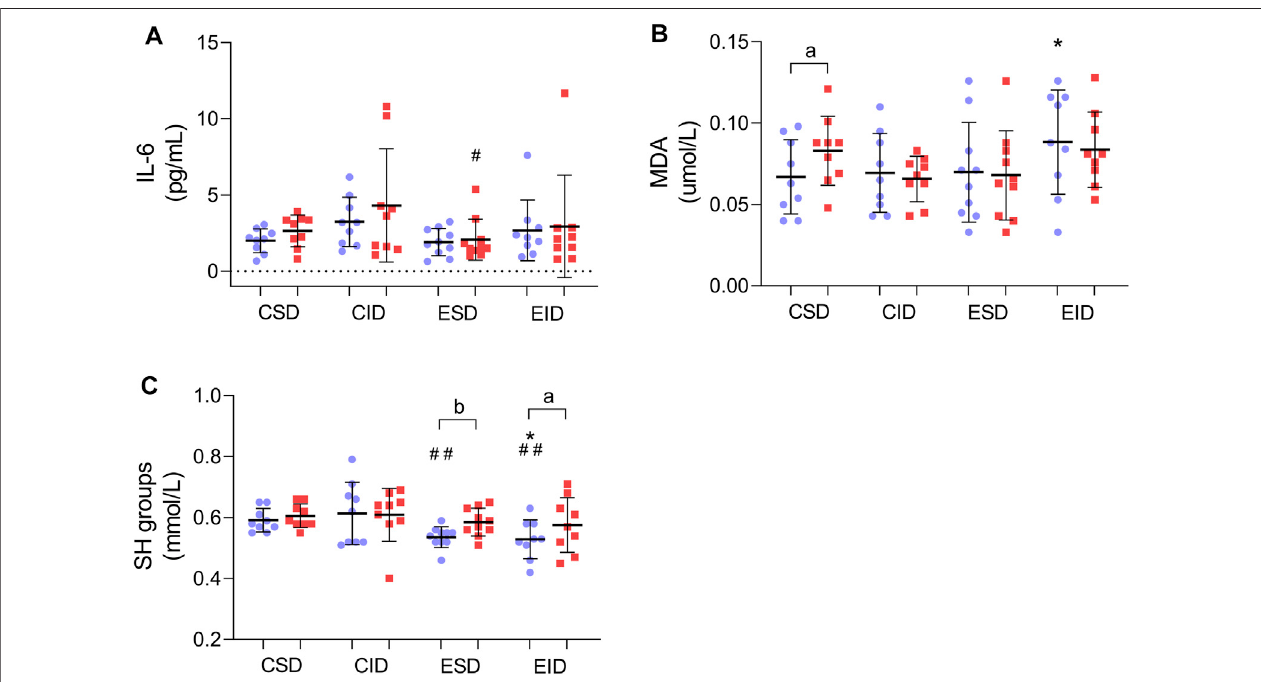
FIGURE 4 | Post-training changes in in fl ammation marker and oxidative stress. (A) IL-6 concentration; (B) MDA concentration; (C) SH concentration. There were signi fi cantdifferencesbetweentheindicatedtime points: a – p < 0.05, b – p < 0.01;betweenthegroups: * p < 0.05vs. CSD;# p < 0.05,## p < 0.01vs. CID.Thedataare presented as the means ± SEM; plain — before the intervention; strips — after the